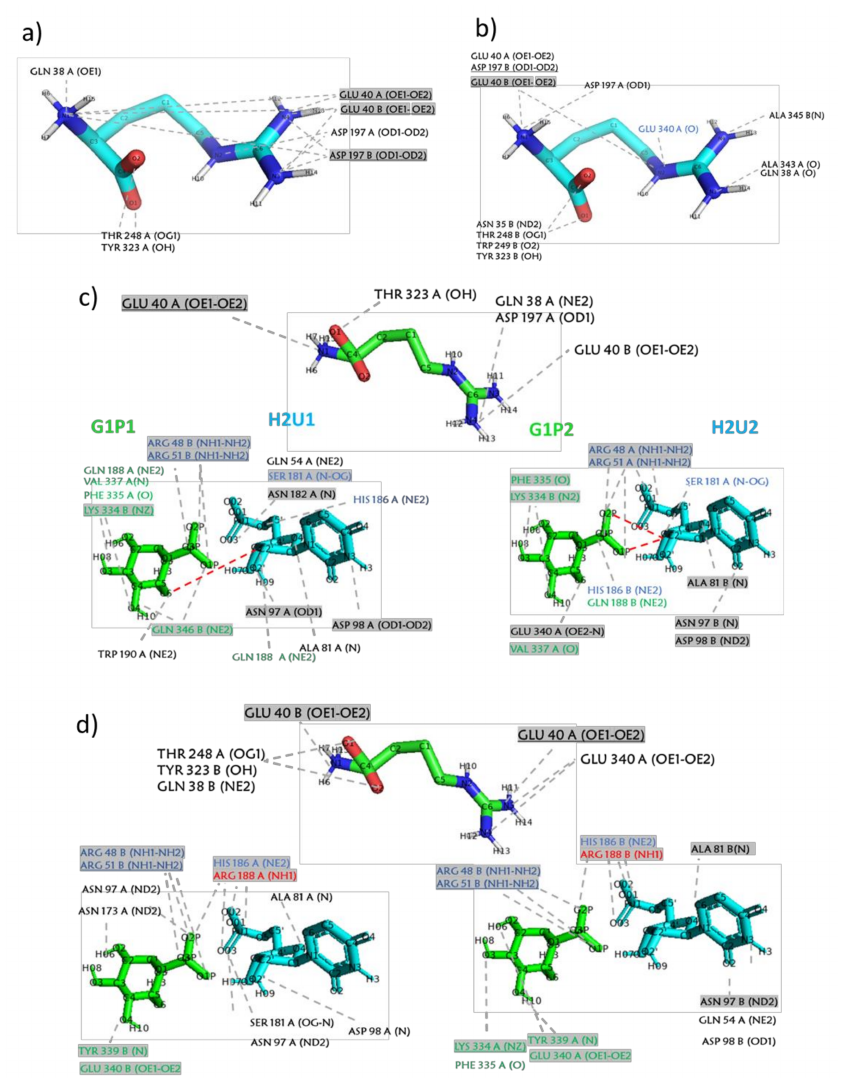
Figure 5. Interactions of arginine in the central cavity with enzyme and ligands. ( a ) Interactions of arginine in the simulation wtGALT + arginine; ( b ) Interactions of arginine in the simulation p.Gln188Arg + arginine; ( c ) Interactions of arginine (top) and of the substrates in the two active sites ( bottom ) in the simulation wtGALT + G1P + H2U + arginine; ( d ) Interactions of arginine ( top ) and of the substrates in the two active sites (bottom) in the simulation p.Gln188Arg + G1P + H2U + arginine. Gray background indicates interactions that persisted for more than 50% of the simulation time. Gray dashed lines indicate H-bonds. Red dashed lines indicate interactions between the